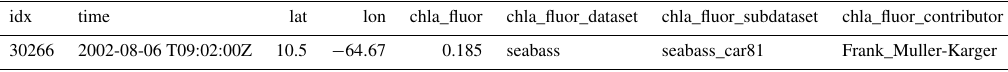
Table B1. Example of what the compiled data looks like. It shows the result when the compilation is queried for chlorophyll data from subdataset